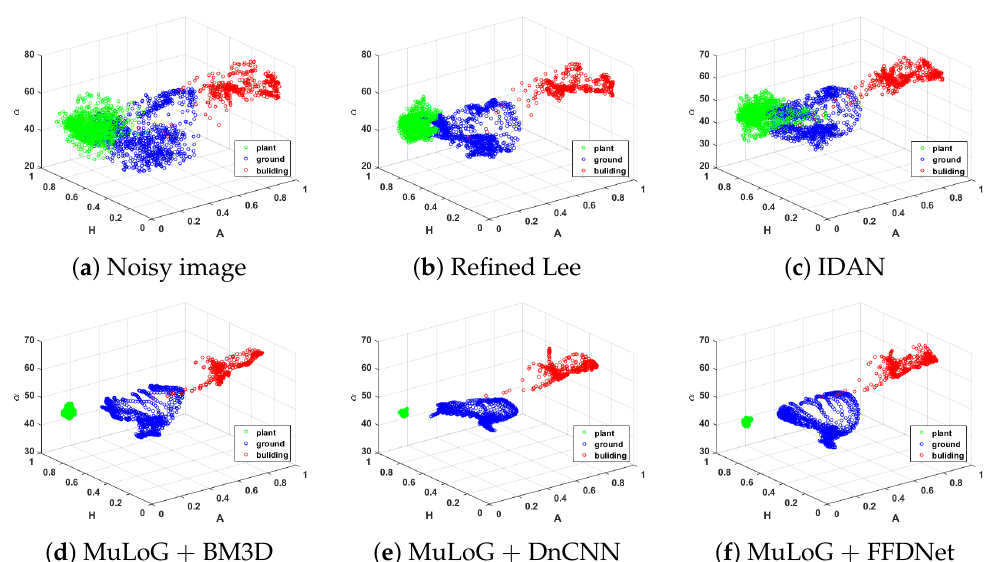
Figure 17. The scatter grams of the Cloude polarimetric decomposition parameters for different areas for CETC-38th airborne SAR with L = 1: ( a – f ) Noisy image, Refined Lee, IDAN, MuLoG + BM3D, MuLoG + DnCNN, and MuLoG + FFDNet, respectively.